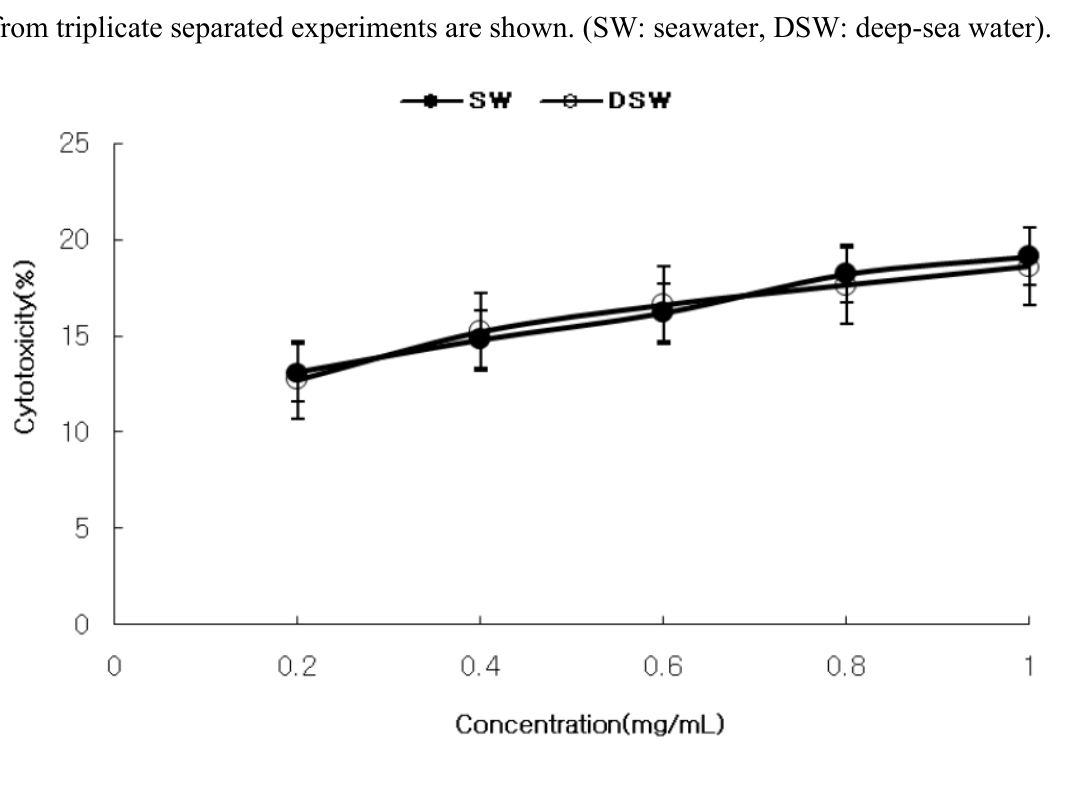
Figure 1. Cytotoxicity of the extracts of S. maxima cultivated in SW and DSW on the normal cell line, HEK 293. SW and DSW extracts were extracted at 100 °C. Mean ± SD